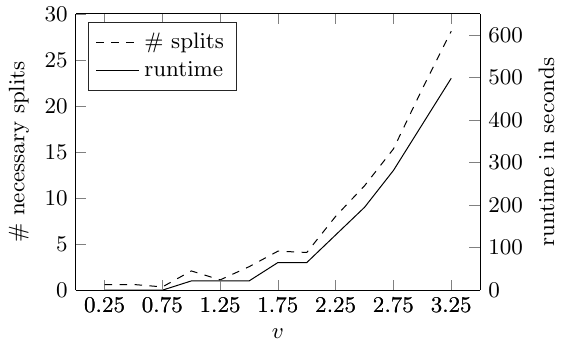
Figure 16: Simulation runtime for different merge